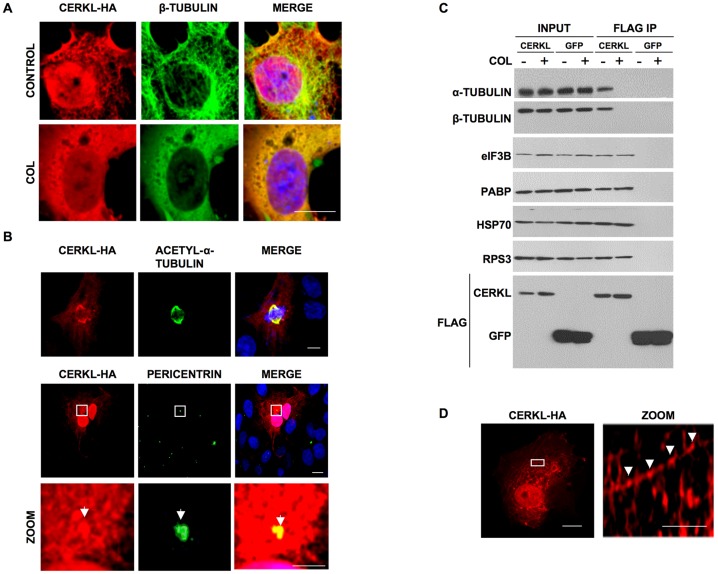
CERKL interacts with microtubules.
A) COS-7 cells overexpressing CERKL were fixed with 2% paraformaldehyde and the localizations of CERKL (HA) and ß-tubulin were compared by immunofluorescence. As control, cells were treated with 1 µg/ml colchicine (COL) for 2 h to disrupt microtubules. Bar: 10 µm. B) CERKL colocalizes with microtubule-related structures. COS-7 transfected cells were fixed with 2% paraformaldehyde and the localization of CERKL (HA) was compared by immunofluorescence with that of acetyl-α-tubulin (upper panels) and the centrosomal protein pericentrin (lower panels, arrowhead) using specific antibodies. Images at higher magnification of the rectangles in the upper row are shown below. All bars: 10 µm. C) Immunoblot of alpha and ß-tubulin, eIF3B, PABP, HSP70 and RPS3 proteins co-immunoprecipitating with CERKL-Flag or GFP-Flag in the presence (+) or not (−) of 1 µg/ml colchicine (COL), as indicated. Bottom, CERKL and GFP in the various lanes using anti-Flag. D) COS-7 cells transfected with CERKL-HA were fixed with 2% paraformaldehyde and CERKL (HA) was localized by immunofluorescence. Images at higher magnification of the rectangles are shown on the right. Arrowheads indicate the particles containing CERKL. Bars: 10 µm (original image) and 2 µm (zoom).